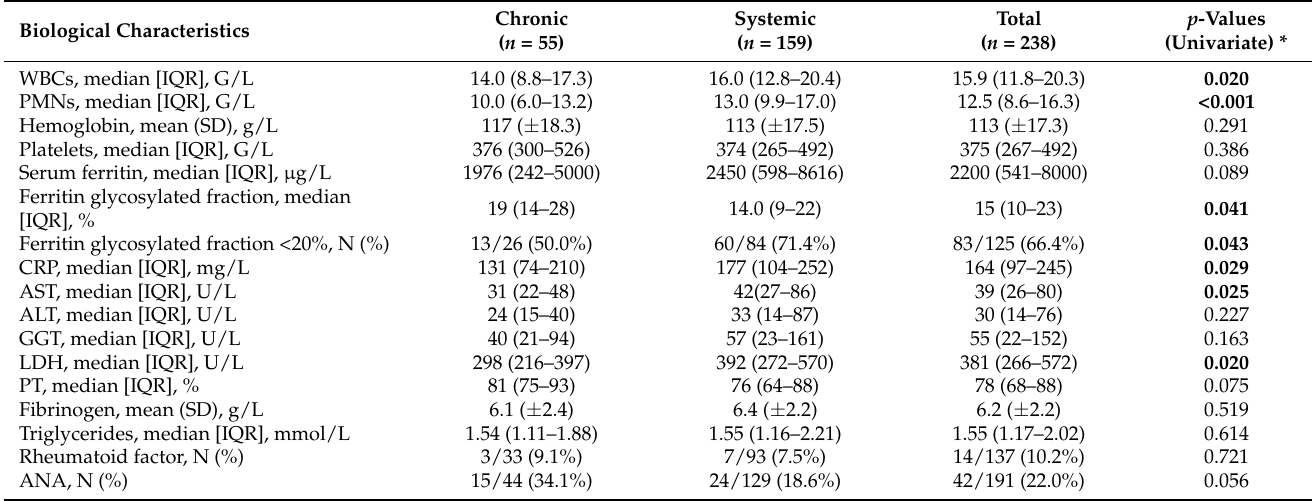
Table 2. Biological characteristics according to the disease